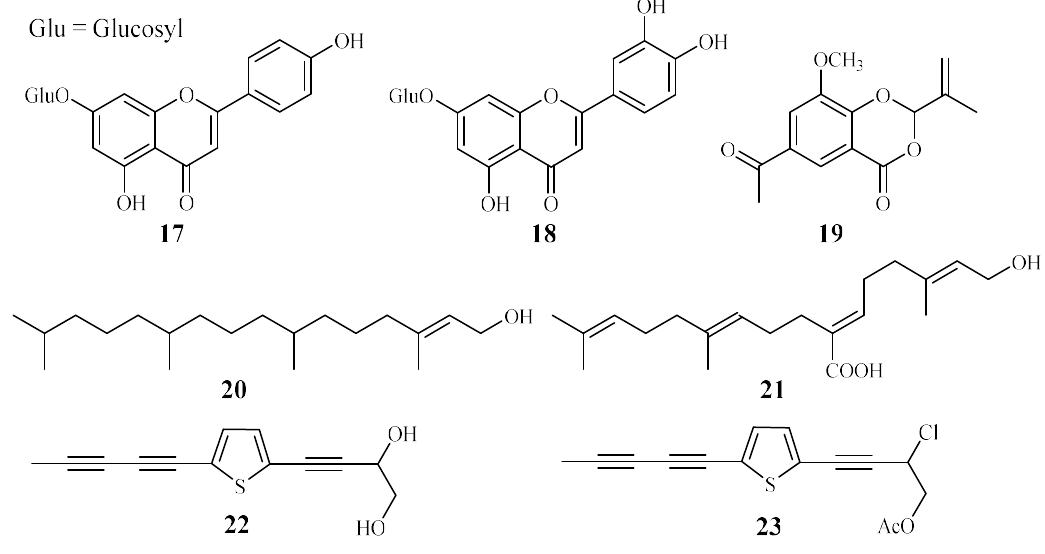
Figure 6. Compounds from Asteraceae plants.